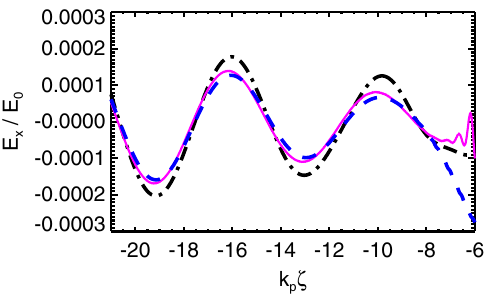
FIG. 9. Transverse electric field driven by a Gaussian and a first-order Hermite-Gaussian pulse as a function of distance behind the laser, at x=r 0 ¼ 0 : 1 , with the two pulses having cross polarized (solid line), the Hermite-Gaussian mode delayed by 2 (cid:1)=! (dashed line), and different frequencies for the two p pulses ( k 1 ¼ 1 : 325 k 0 ) (dash-dotted